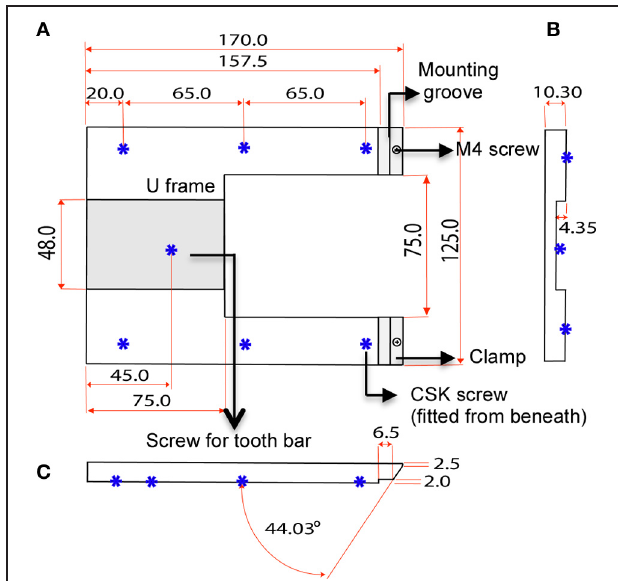
FIGURE 2 | Dimensions of U frame. (A) Top view shows the position of the clamps and 6 CSK screws fitted from beneath. The screws bolt the “U” frame to the base plate. (B) Section view shows the concavity of the U frame that makes provision for a tooth bar. (C) Side view shows the angle of the clamp in relation the U frame.